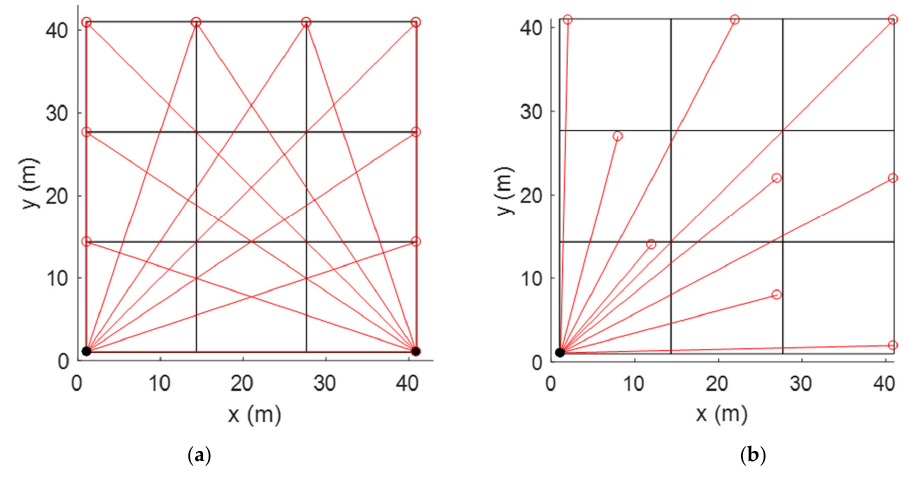
Figure 2. ( a ) Overlapped path configuration. ( b ) Non ‐ overlapped path configuration.